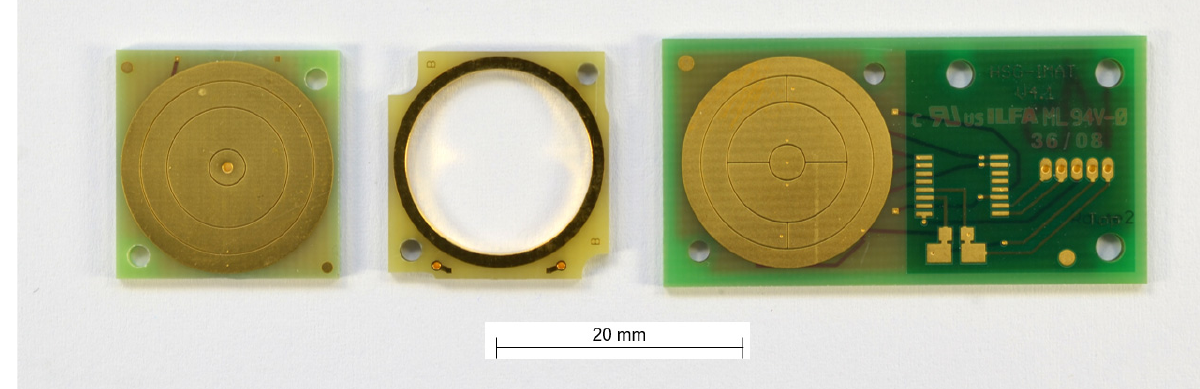
Figure 17. Components of the PCB sensor; top, middle, and bottom PCB.